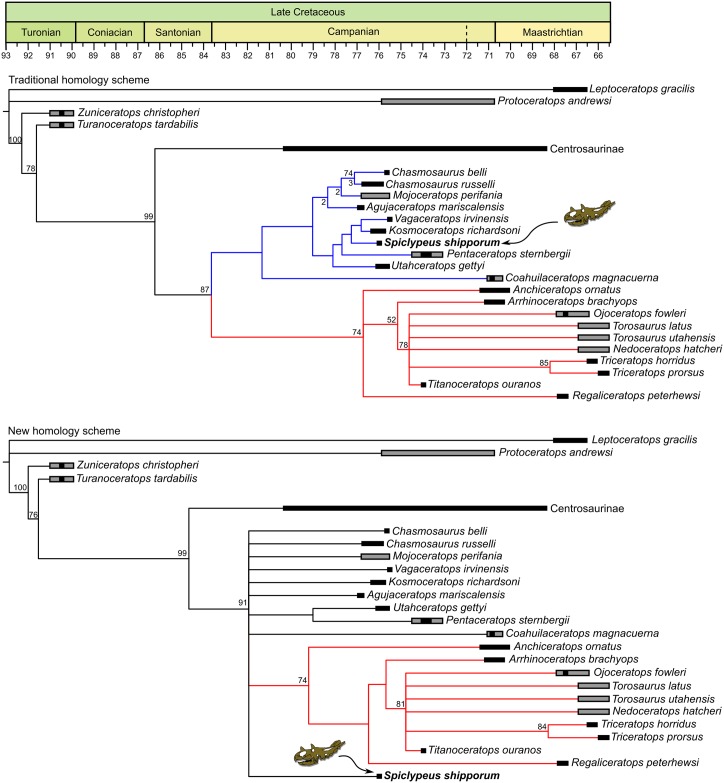
Cladograms showing evolutionary relationships within Chasmosaurinae.Top: reduced strict consensus tree assuming traditional homology scheme for epiparietals (tree length = 332 steps, consistency index = 0.5873, retention index = 0.7345); Bottom: reduced strict consensus tree assuming new homology scheme for epiparietals (tree length = 439 steps, consistency index = 0.4487, retention index = 0.5346). Blue branches indicate ‘Chasmosaurus clade’ described in text; red branches indicate ‘Triceratops clade’. Numbers above nodes indicate bootstrap values >50%; numbers beneath nodes indicate Bremer support values >1.